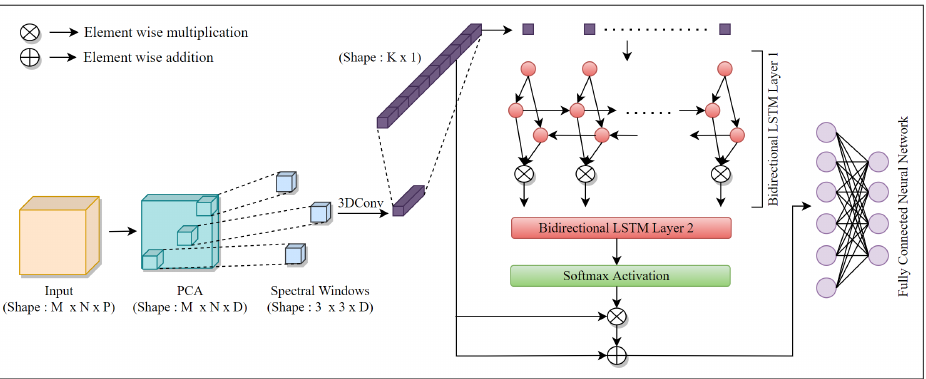
Figure 1. The proposed 3D-convolution and bidirectional LSTM-based attention and classification architecture